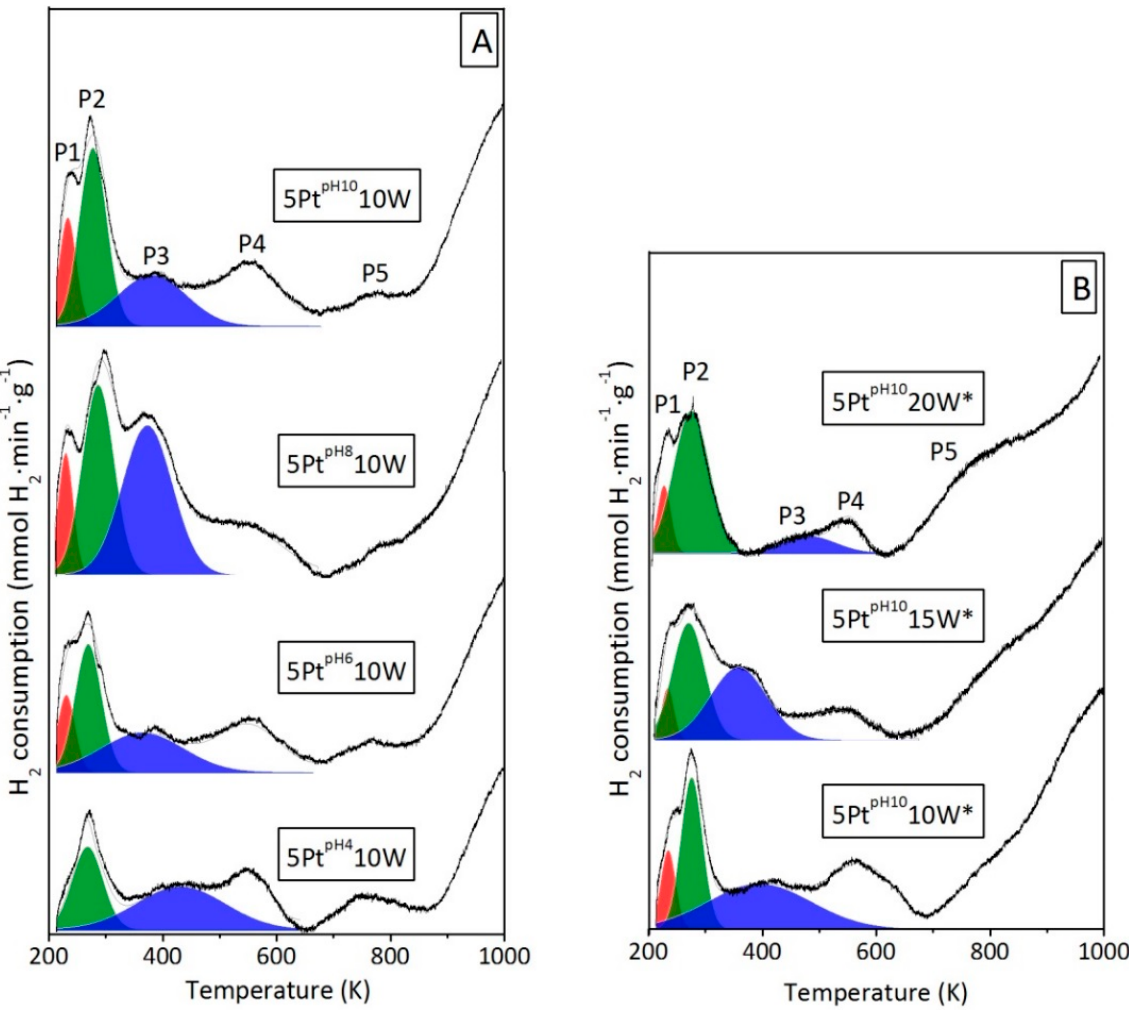
Figure 1. H 2 -TPR profiles for different Pt/WO x /Al 2 O 3 catalysts. Effect of the Pt impregnation pH ( A ) and the W impregnation pH ( B ). The * symbol refers to the pH value of 1.5 during tungsten impreg- nation.